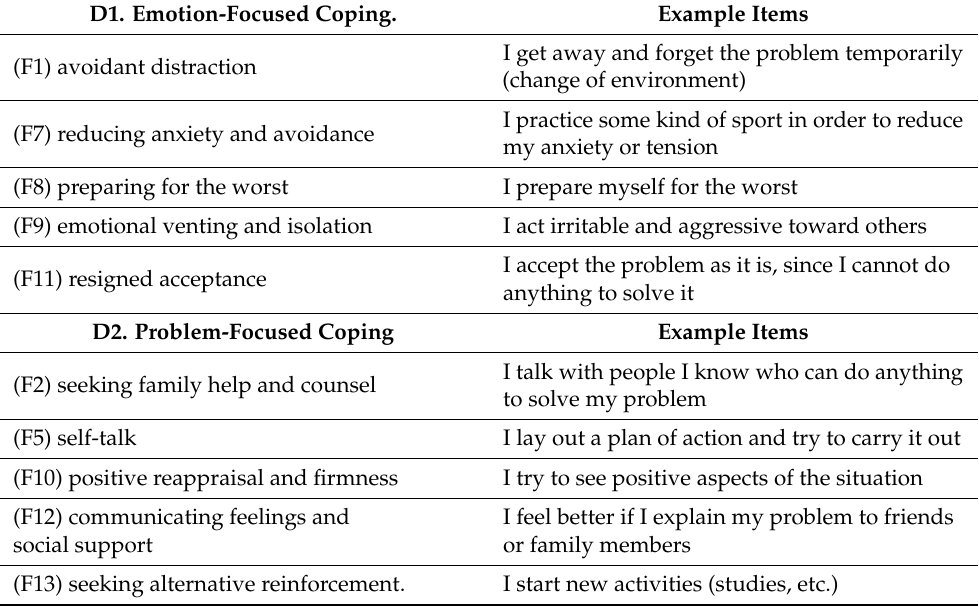
Table 1. Factors and dimensions of the Coping Strategies of Stress Scale (EEC)-short [97]. Reproduced with permission from de la Fuente, J., International Journal of Environmental Research and Public Health; published by MDPI,